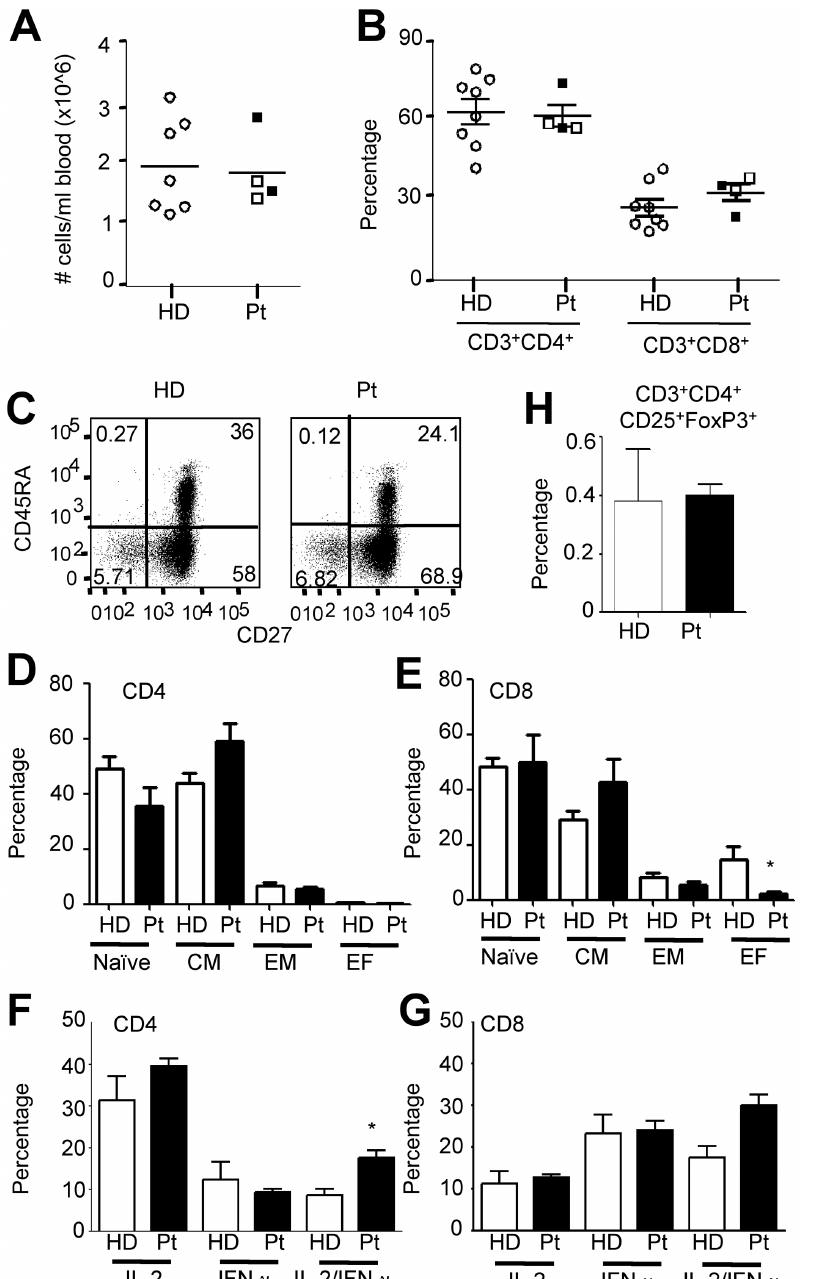
Figure 1. TSC subjects with germline mutation of TSC1 reveal proper representation of CD4 and CD8 mature T cell subsets. PBMC from healthy donors and TSC subjects were isolated by density gradient centrifugation, counted and surface stained with anti-CD3, CD4, CD8, CD45RA and CD27 mAb and analyzed by FACS. A–B) Viable cell counts per ml of blood and the frequency of CD4 + and CD8 + cells within CD3 + lymphocytes is depicted for individual subjects. Open squares refers to Pt1 and 2 carrying the Leu129Pro mutation, black squares refers to Pt3 and 4 carrying a stop codon mutation in the position of Arg692. C–E) Distribution of naı¨ve (Naı¨ve, CD45RA high CD27 high ), central memory (CM, CD45RA low CD27 high ), effector memory (EM, CD45RA low CD27 low ) and terminally differentiated effectors (EF, CD45RA high CD27 low ) within CD3 + CD4 + (C, D) or CD3 + CD8 + (E) cells is depicted. F–G) Freshly isolated PBMC were stimulated for 4 h with PMA and Ionomycin. Expression of IL-2 and IFN- c was determined by intracellular cytokine staining. Results depict the frequency of cytokine secreting cells after gating on CD3 + CD4 + (F) or CD3 + CD8 +